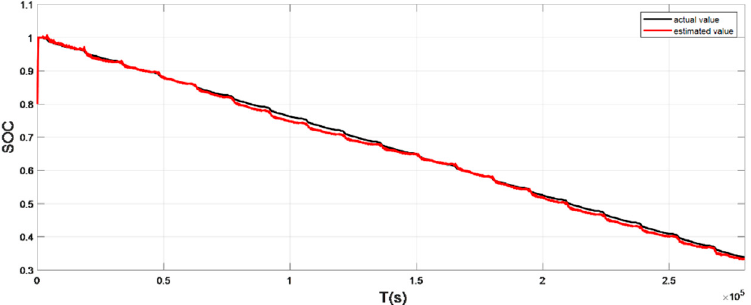
Figure 10. Comparison of the SOC real value and estimated value under UDDS (low temperature: 0 °C).